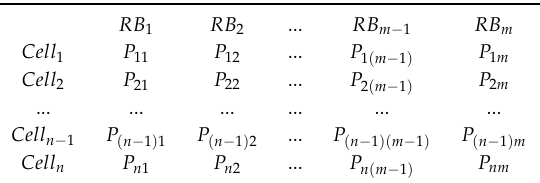
Table 3. Power allocation